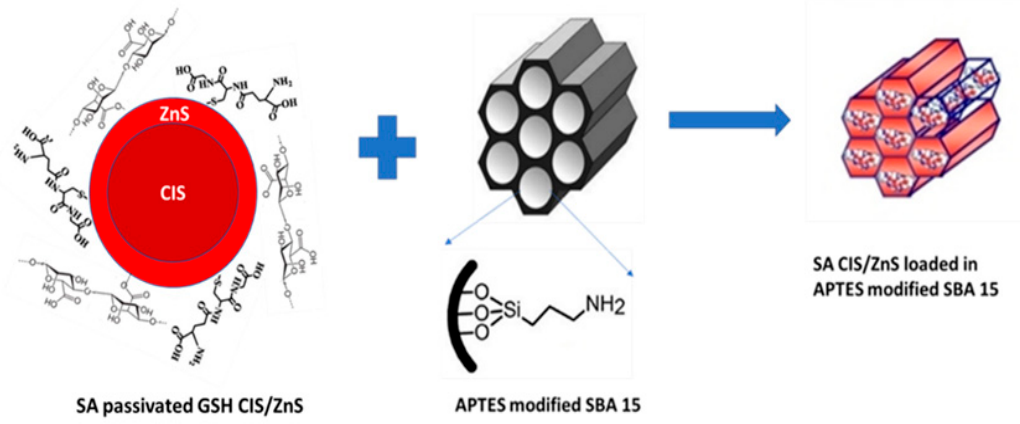
Figure 17. Schematic representation of the encapsulation of sodium alginate passivated CIS/ZnS QDs in amine-modified mesoporous silica [3].